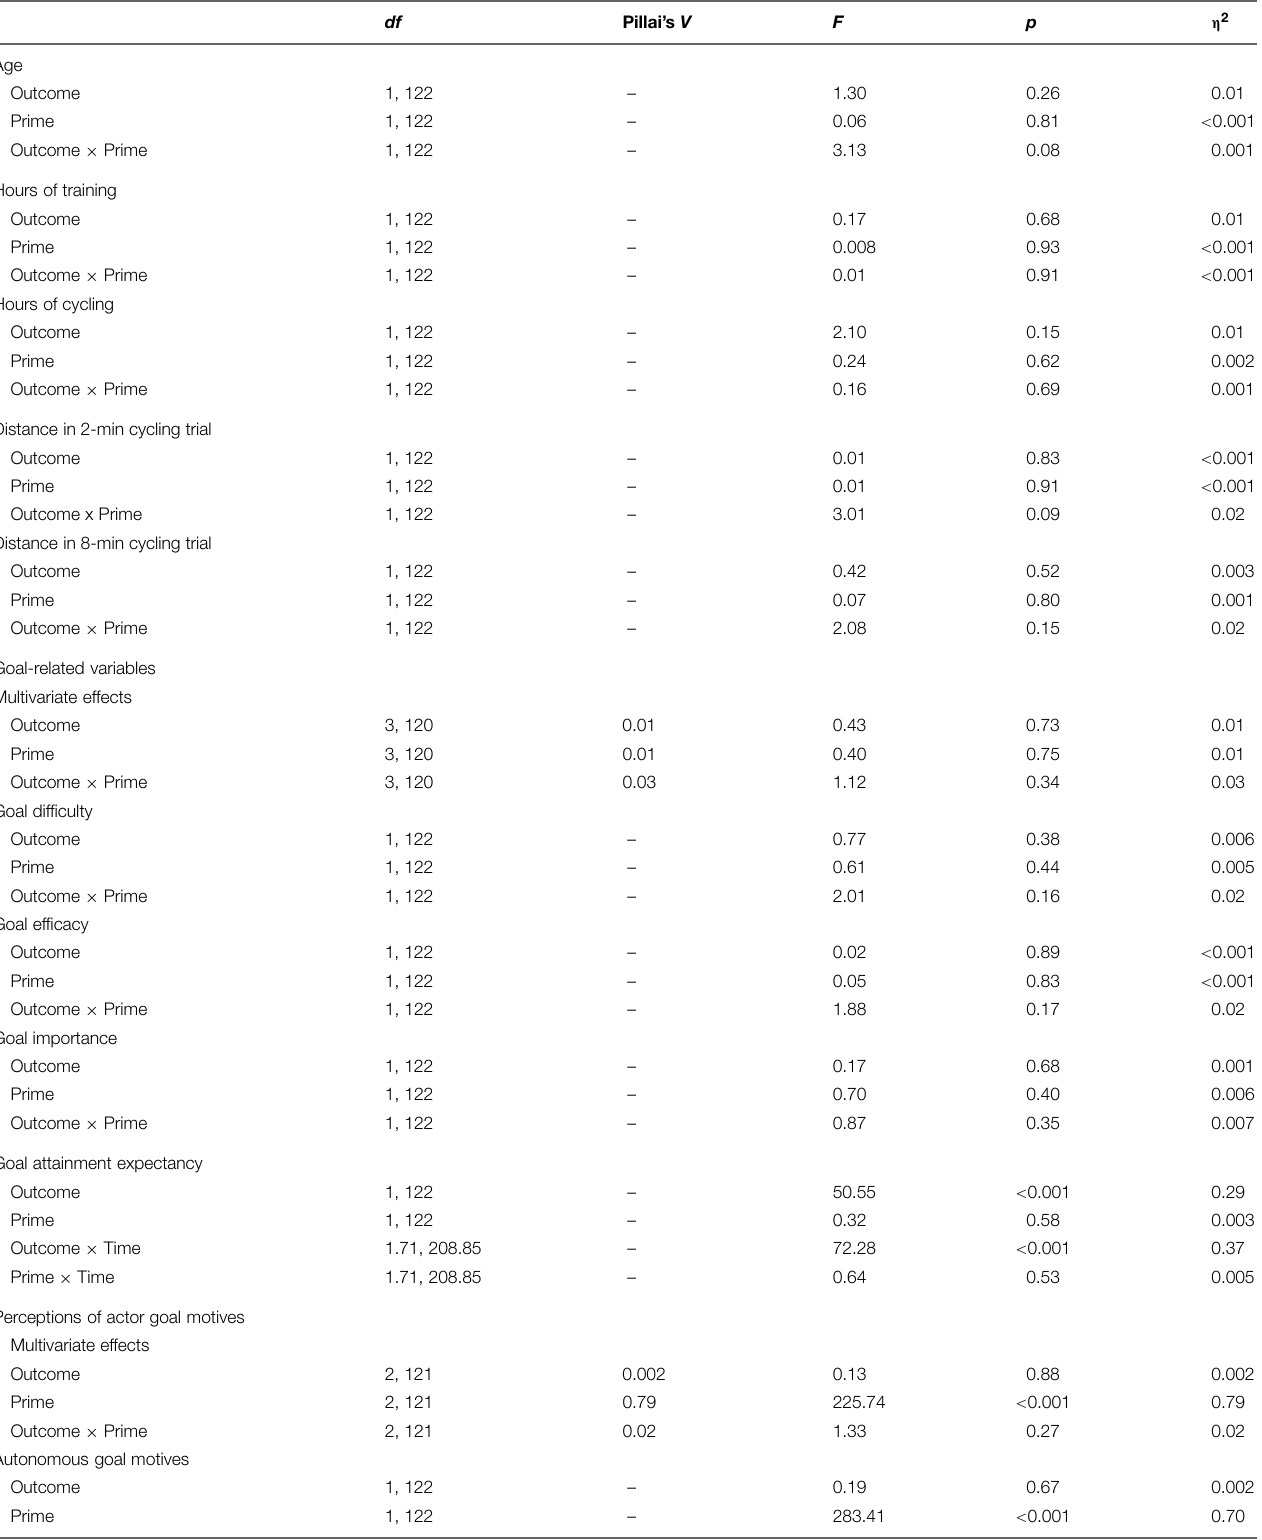
TABLE 2 | Results of analyses of variance (ANOVAs) and multivariate analyses of variance (MANOVAs) conducted as preliminary analyses and manipulation checks. df Pillai’s